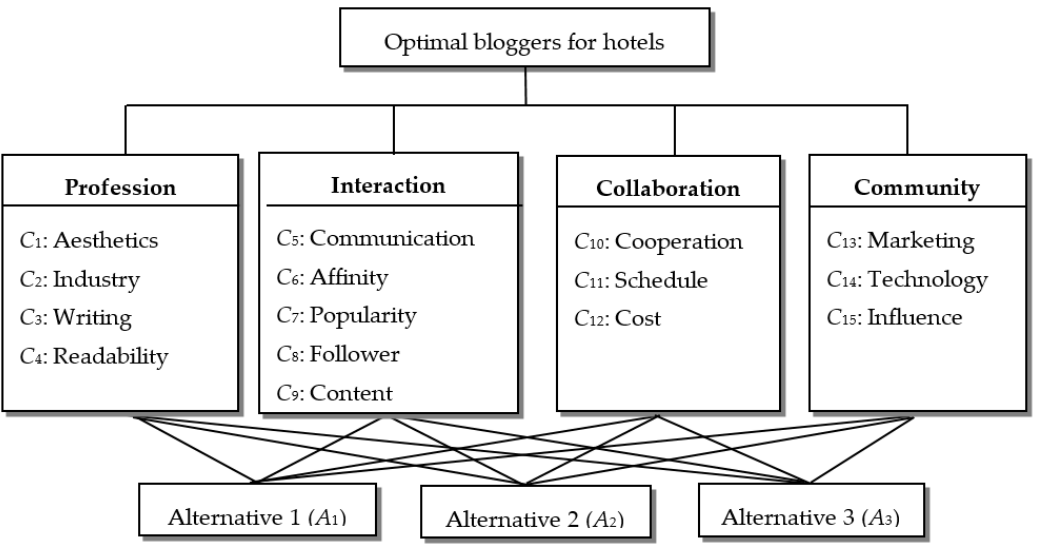
Figure 2. The hierarchical structure to select the optimal bloggers for hotels. Table 5. The integrated weights of criteria.